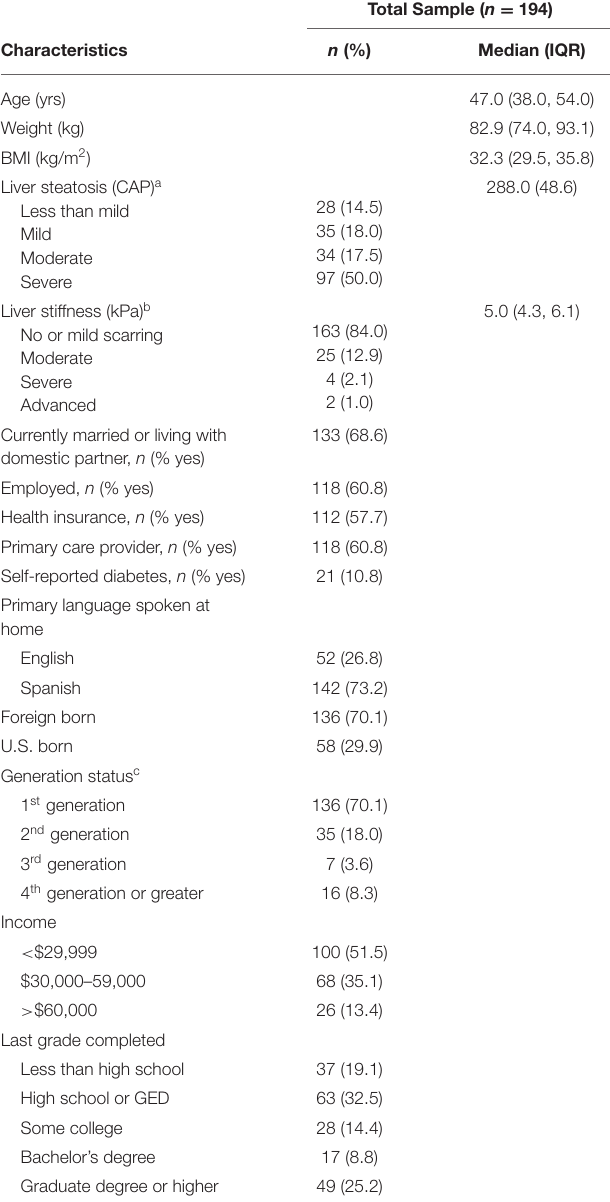
TABLE 1 | Characteristics of Mexican-origin female participants ( n =